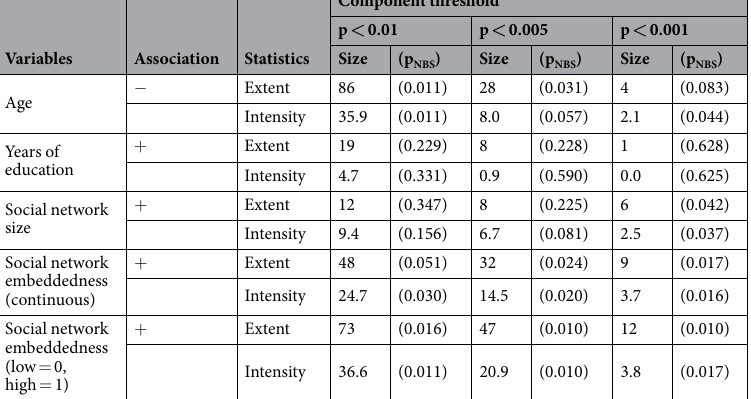
Table 2. Network Based Statistics (NBS) for testing component-level associations between functional connectivity and individual characteristics (n = 64). Note: From each set of ROI-pairs selected by pair-level tests with three different thresholds of p < 0.01, p < 0.005, and p < 0.001, NBS detects the largest ROI-component based on the extent (the number of ROI-pairs) or intensity (the extent weighted by the strength of associations), and calculates p-values (p NBS ) from the rate of cases where empirical brain networks have larger extent or intensity than 5,000 simulated networks. All the analyses were performed with covariates of gender, MMSE score, age, years of education, social network size, and social network embeddedness. The continuous form of social network embeddedness was used when testing the hypotheses for other major